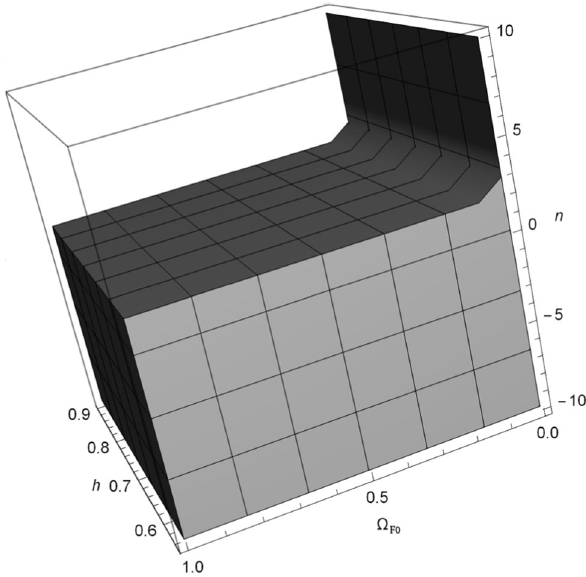
Fig. 2 The parameter space of the hyperbolic tangent-power model (32) that is consistent with the BBN constraints. If we also desire the model to be able to describe dark energy in the late-time Universe we obtain the combined constraint n (cid:2) 1 .